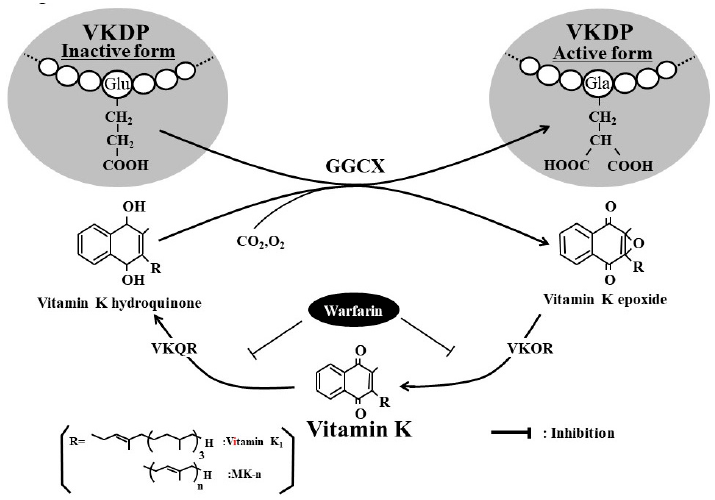
Figure 1. Activation of vitamin K-dependent protein (VKDP) by vitamin K and γ -glutamyl carboxylase (GGCX). Vitamin K is a cofactor for GGCX, which is responsible for converting specific glutamic acid (Glu) residues to γ -carboxylated glutamic acid (Gla) residues in VKDPs such as prothrombin, osteocalcin (OC), and matrix Gla protein (MGP). Vitamin K plays a role in normal blood coagulation via the γ -carboxylation of coagulation factors (II, VII, IX, and X), increases bone strengthen via the γ -carboxylation of OC, and suppresses arterial calcification via the γ -carboxylation of MGP. In vitamin K insufficiency or deficiency, undercarboxylated VKDP, an inactive form of VKDP, is released from the target organ. Thus, serum levels of undercarboxylated VKDPs are a sensitive marker of vitamin K status. VKOR, vitamin K epoxide reductase; VKQR, vitamin K quinone reductase.